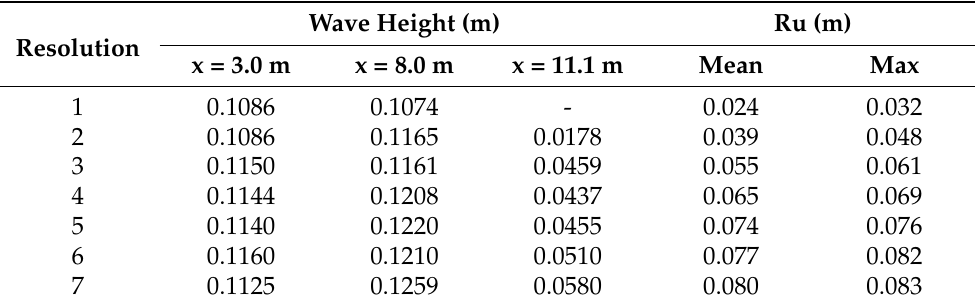
Table 10. Run-up case: mean wave height at gauges located at x = 3.0, 8.0, 11.1, and 12.06 m and the mean and maximum run-up obtained in DualSPHysics.